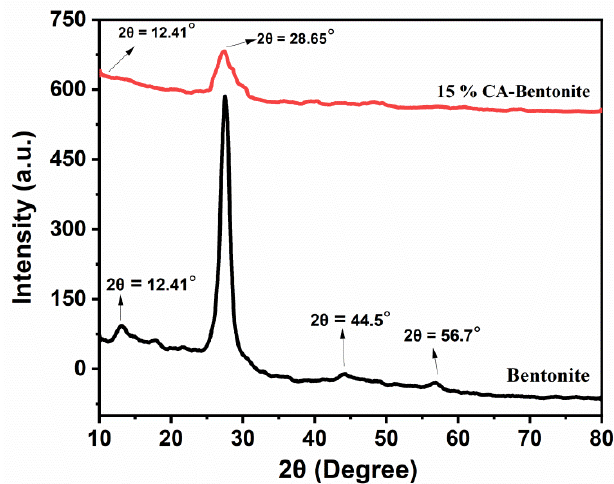
Figure 3. XRD spectrum of raw and cinnamic acid modified bentonite clay.